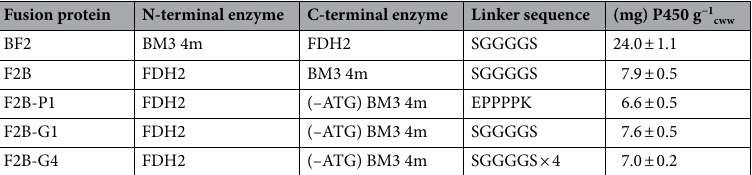
Table 1. Fusion constructs consisting of BM3 4m and formate dehydrogenase FDH2. Constructs that lack the ATG start codon are marked as (–ATG). The linkers are displayed as the corresponding amino acid sequences. The quantification of expression levels was conducted by recording CO-difference spectra with cell lysates. Subsequently, the concentration was normalized to cell wet weight. Each value is depicted as the mean of triplicate measurement and error bars represent the standard